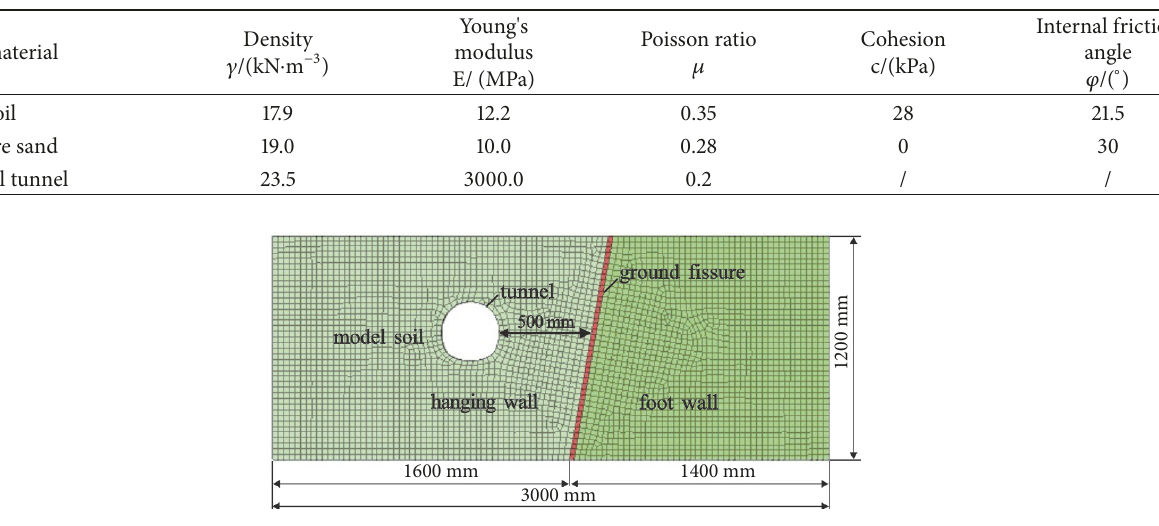
Table 3: Parameters of numerical model.